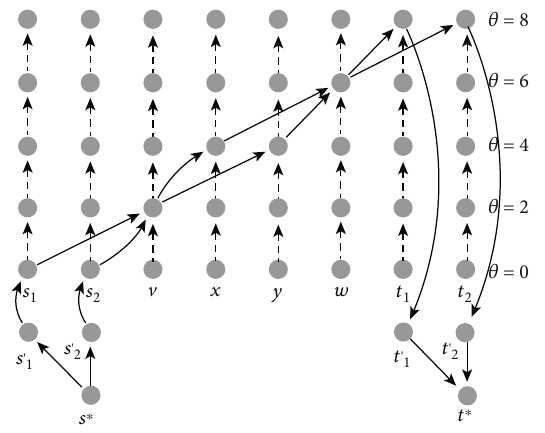
Figure 6: Δ -condensed time-expanded network of Figure 2(b) after scaling capacity and transit time. Table 2: Maximum dynamic multicommodity fl ow before and after lane reversals. Δ -condensed time-expanded graph